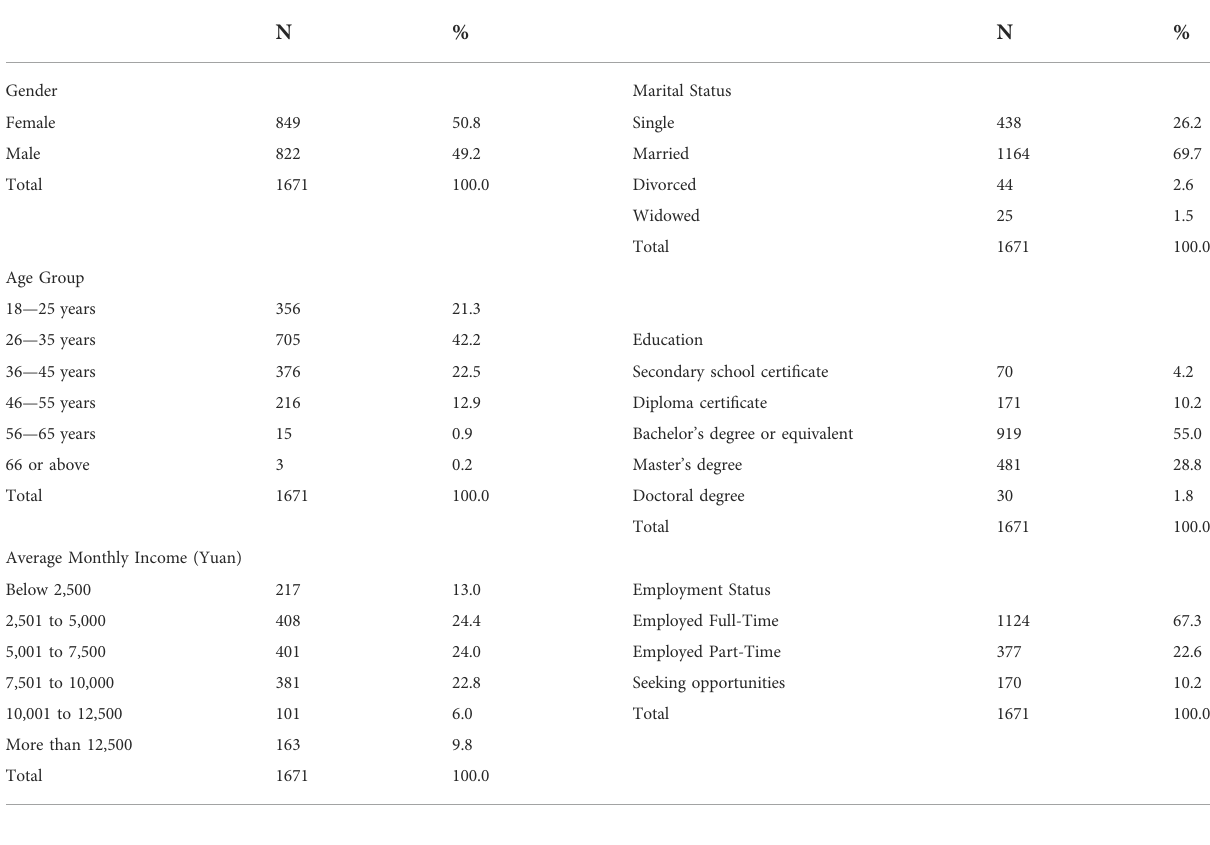
TABLE 2 Demographic characteristics.